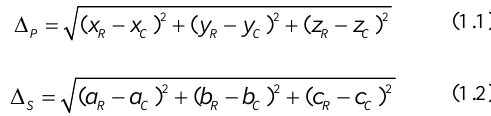
5. APPROXIMATION WITH MBBS